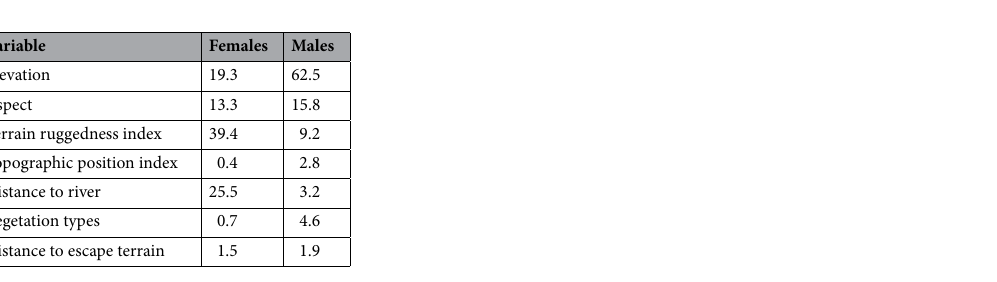
Table 1. Importance of the habitat variables to the Maximum entropy model. The values of importance was normalized to percentages.